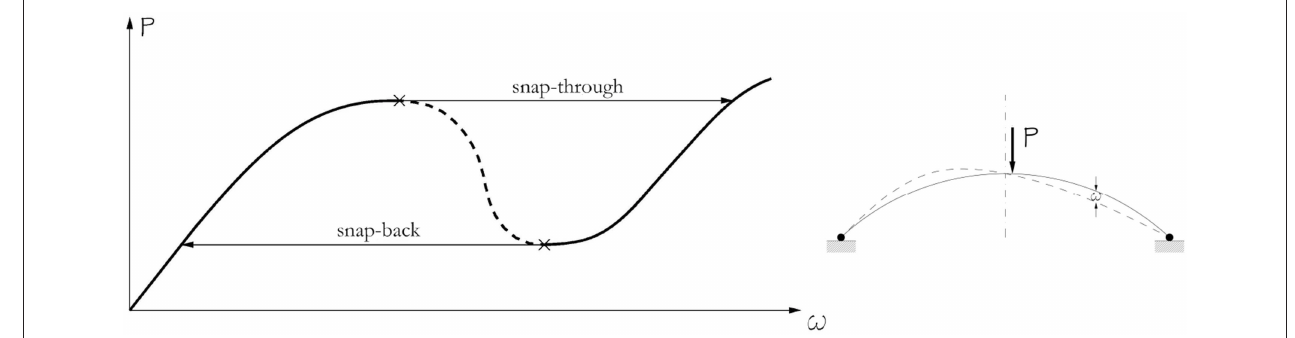
FIGURE 4 | Codimension-2 cusp bifurcation of a shallow elastic arch. Unless otherwise stated, continuous and dashed lines represent stable and unstable equilibria,